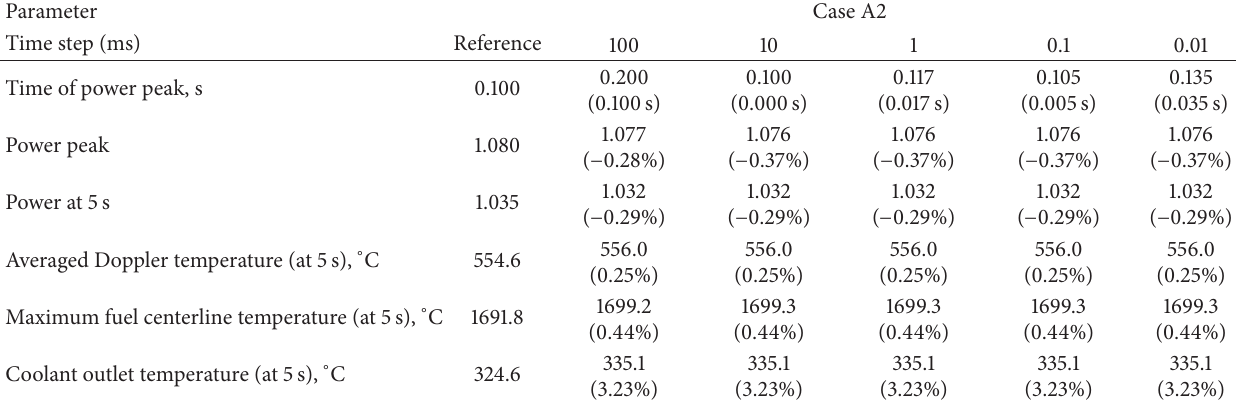
Table 7: Sensitivity analysis results in the maximum time step for case A2.